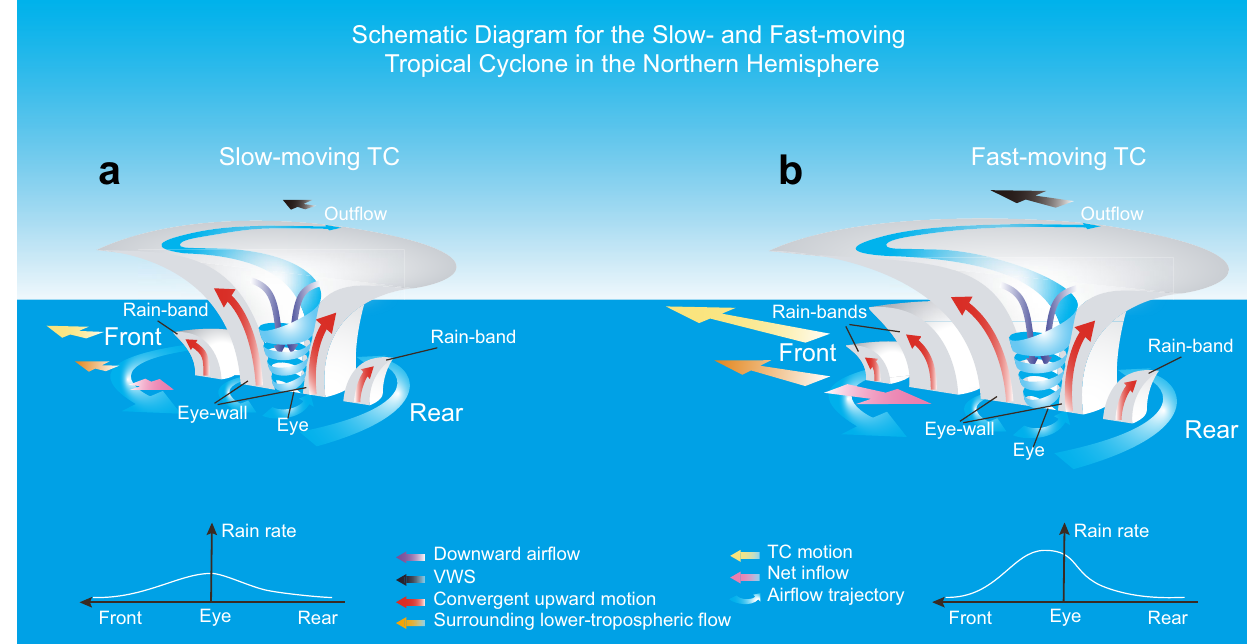
Fig.4|Schematicdiagramsofthetranslatingtropicalcyclone(TC).a Theslow- movingTC, b thefast-movingTC.Thelegendofcoloredarrowsislistedatthelower ofthis fi gure.Thewhitecurvesaretheschematicdiagramforthefront-rearsection